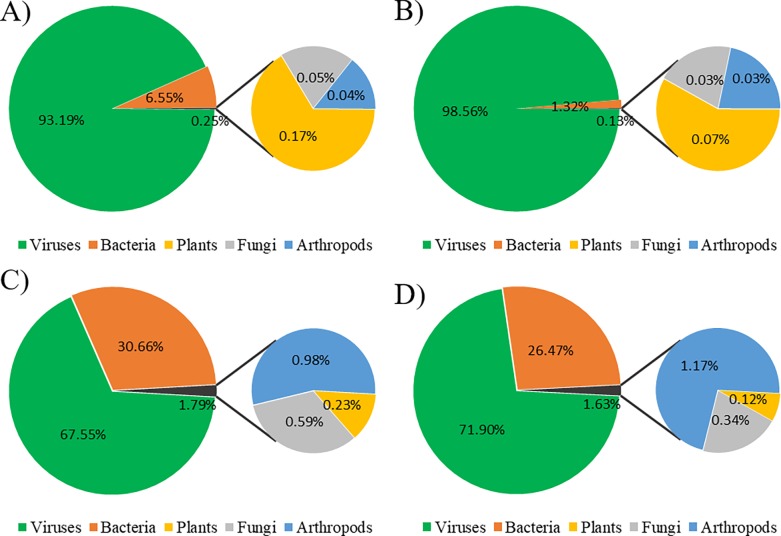
Proportion of reads assigned to the five organism groups in the orange tree and eucalyptus tree blossom honeys using different sequence identity.Orange tree blossom honey: sequence identity ≥ 75% (A) and ≥ 97% (B); eucalyptus tree blossom: sequence identity ≥ 75% (C) and ≥ 97% (D). Percentages are computed considering only reads annotated at the taxonomic rank of species (see Table 3).